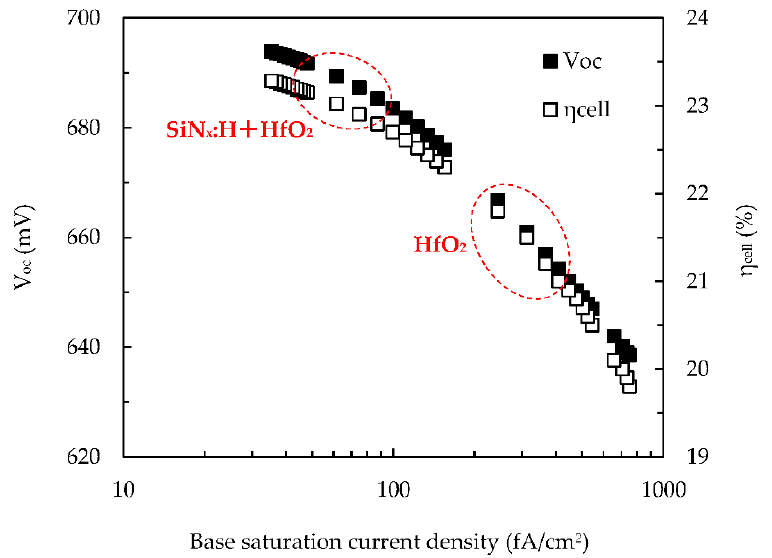
Figure 5. Open-circuit voltage and conversion efficiency of n-type PERC solar cells as a function of base saturation current density.